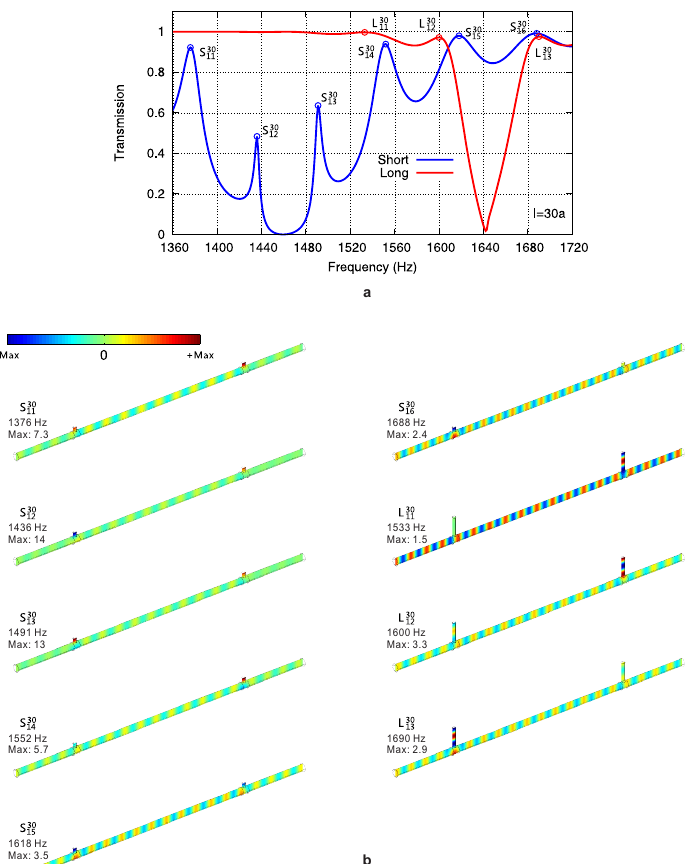
Figure 7. Case of two resonators grafted onto a waveguide at distance l = 30 a (l ∼ 10 λ ). ( a ) transmission spectra are shown for two short tubes (solid blue line) or two long tubes (solid red line); ( b ) normalized pressure distributions are shown at the remarkable frequencies indicated in ( a ). The color scale is for pressure normalized with respect to the maximum pressure